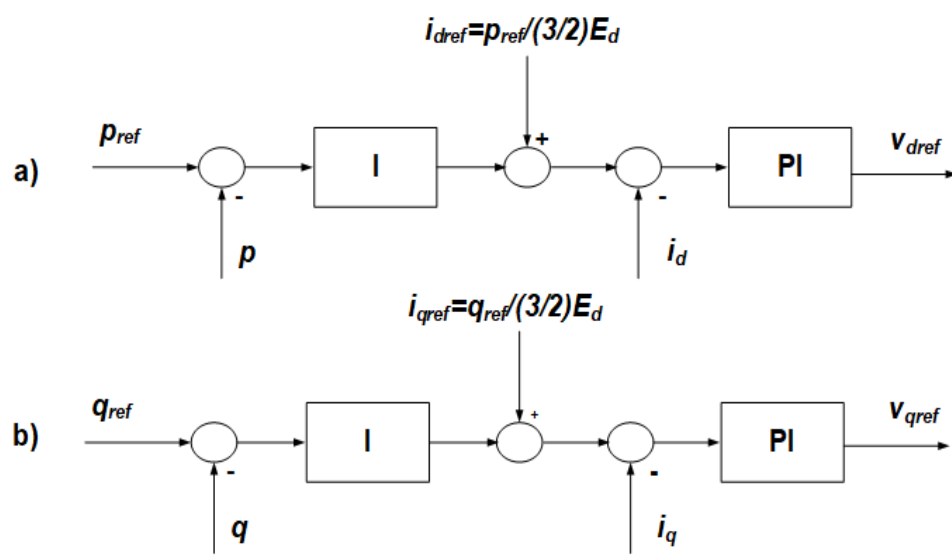
Figure 4. BES three phase converter control. ( a ) Active power control. ( b ) Reactive power